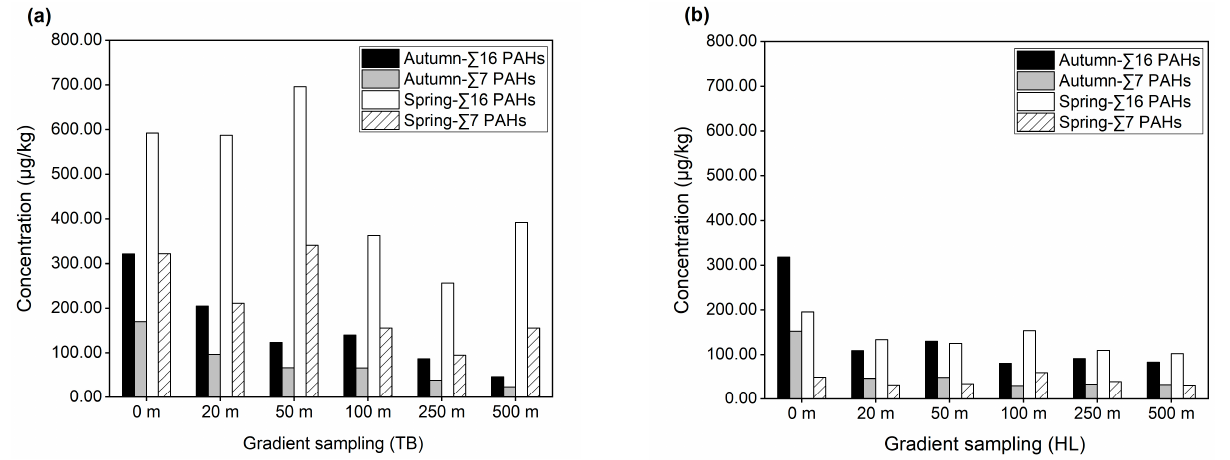
Figure 5. Concentration of PAHs with distance in farmland soil in autumn and spring. ( a ) Gradient sampling area Tanbu Town, Huadu District (TB); ( b ) gradient sampling area Hengli Town, Nansha District (HL).